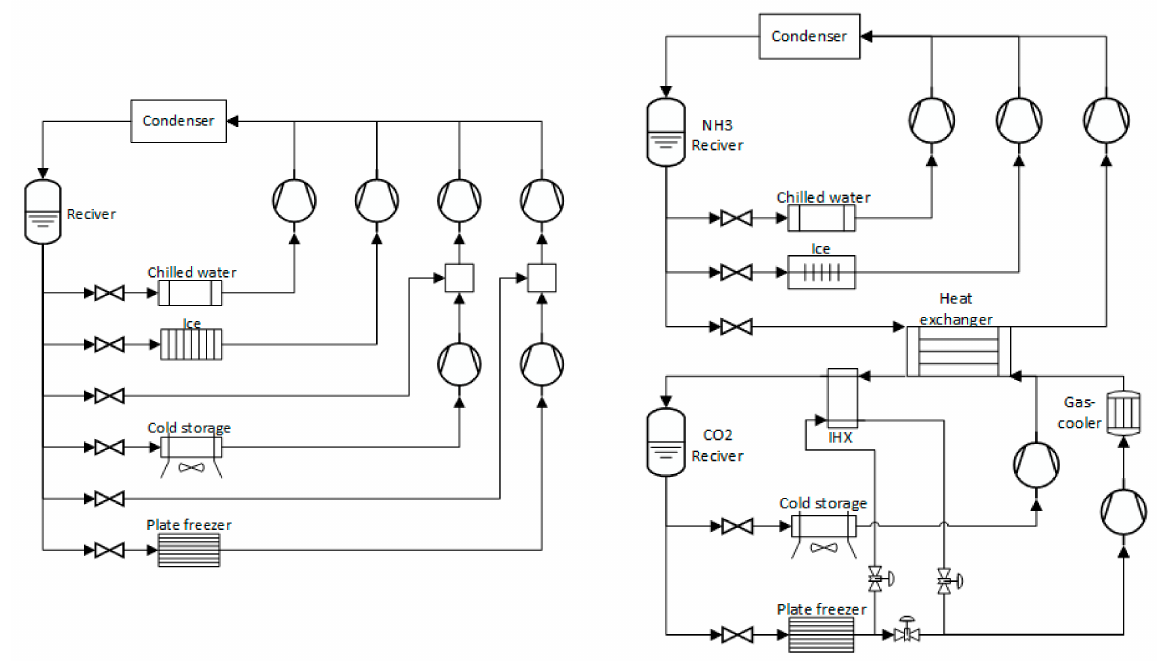
Figure 4. Schematic diagrams for baseline ammonia system ( left ) and a cascade refrigeration system ( right ), adapted from [37].